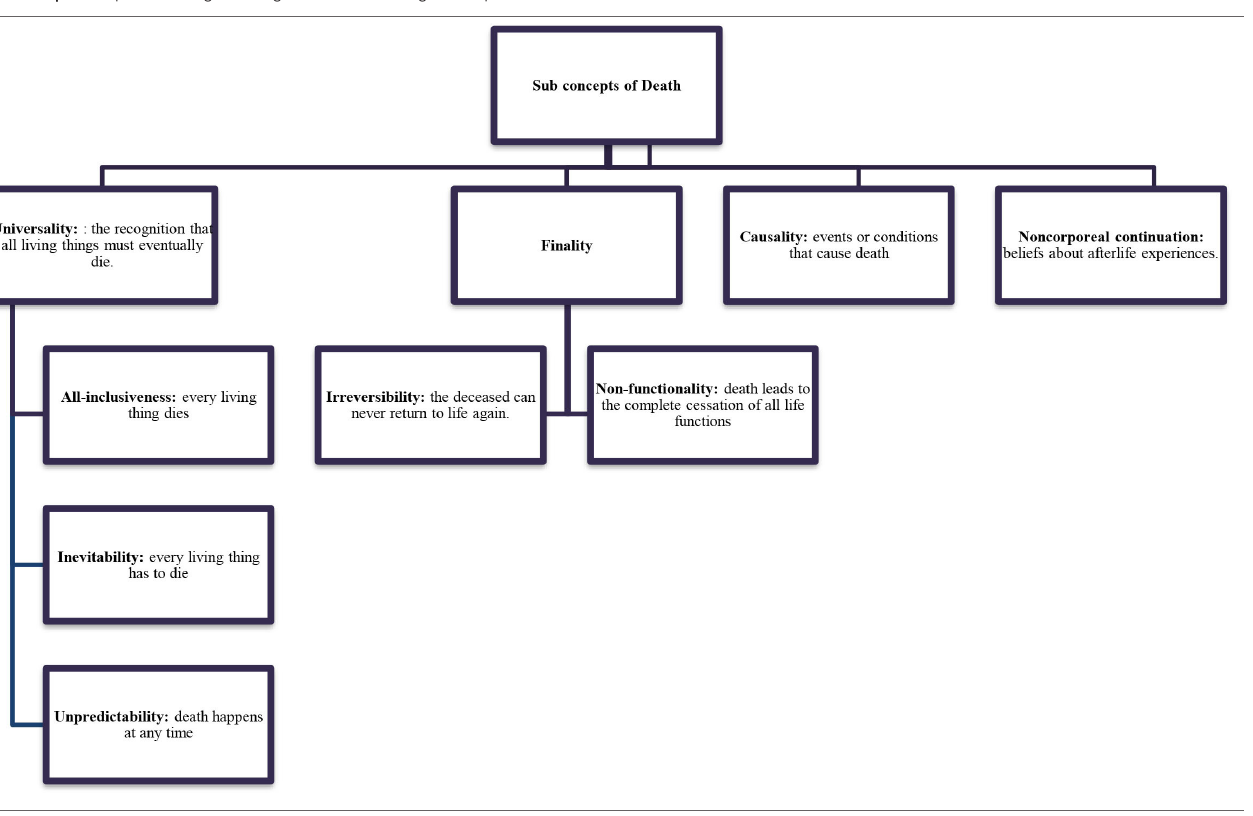
TABLE 2 | Developmental stages during childhood and cognitive representation of